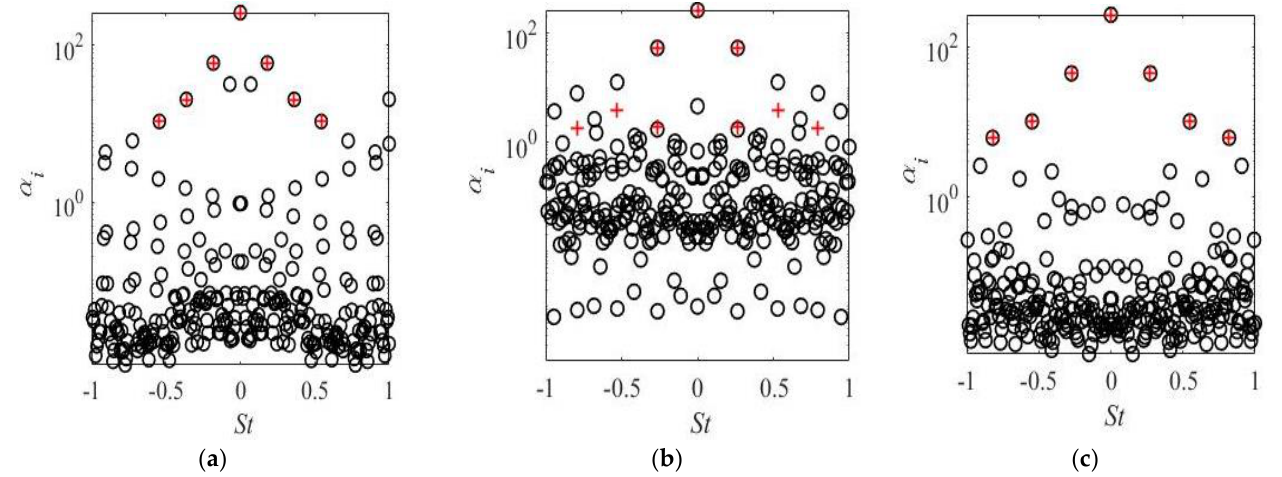
Figure 14. The DMD spectrum for different distance ratios. The black circles denote the eigenvalues obtained using the original DMD and the red crossings denote the eigenvalues obtained using the SPDMD: ( a ) 𝐿/𝐷 = 1.8 ; ( b ) 𝐿/𝐷 = 2.5 ; ( c ) 𝐿/𝐷 = 3 .